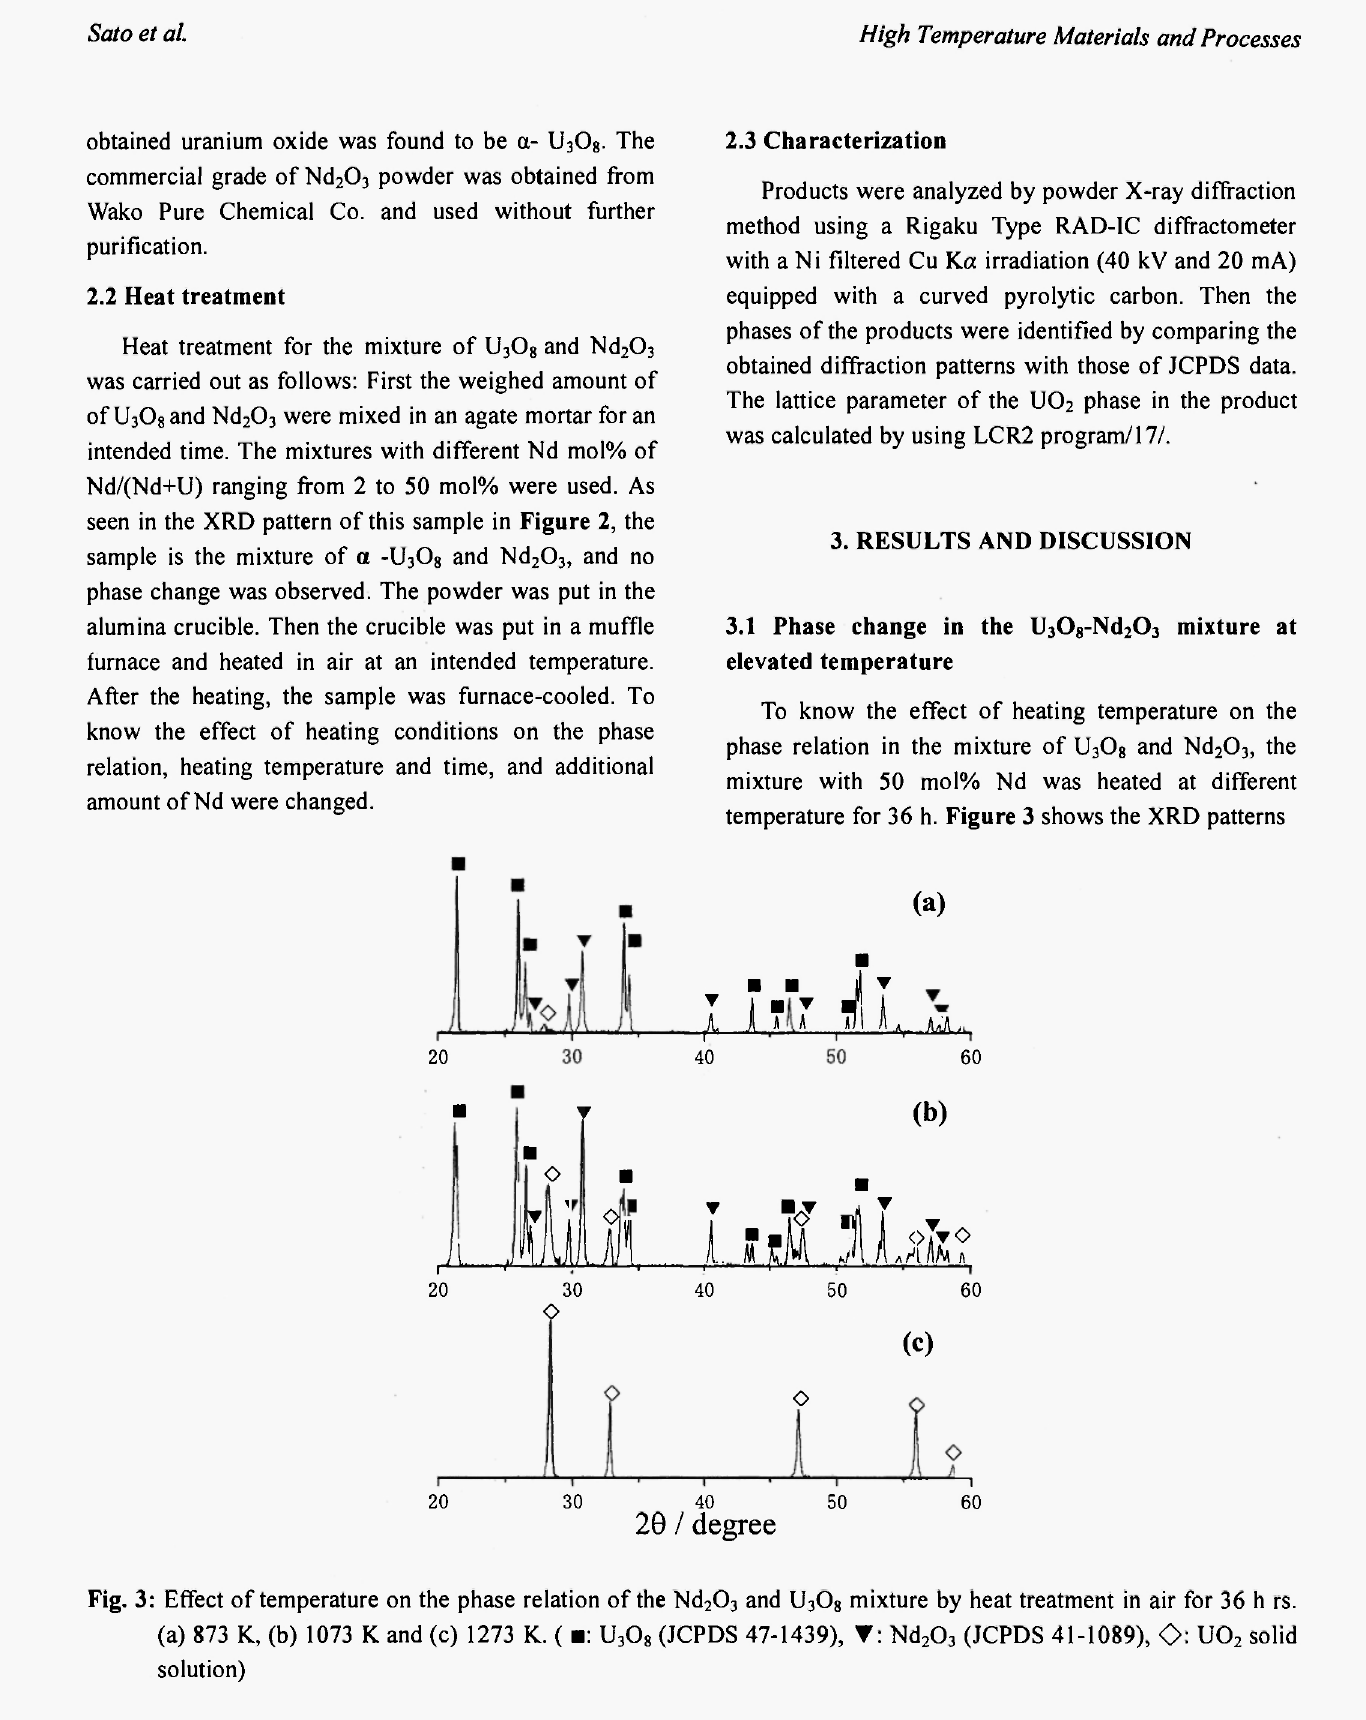
Fig. 3: Effect of temperature on the phase relation of the Nd 2 0 3 and U 3 0 8 mixture by heat treatment in air for 36 h rs. (a) 873 K, (b) 1073 Κ and (c) 1273 K. ( •: U 3 0 8 (JCPDS 47-1439), •: Nd 2 0 3 (JCPDS 41-1089), O: U 0 2